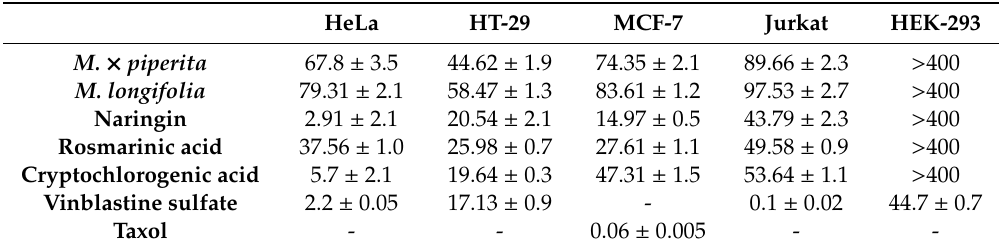
Table 3. Antiproliferative activities [IC 50 ( µ g / mL)] of the M. × piperita and M. longifolia leaf extracts and the individual compounds on di ff erent cancer cells (presented in µ g / mL ±